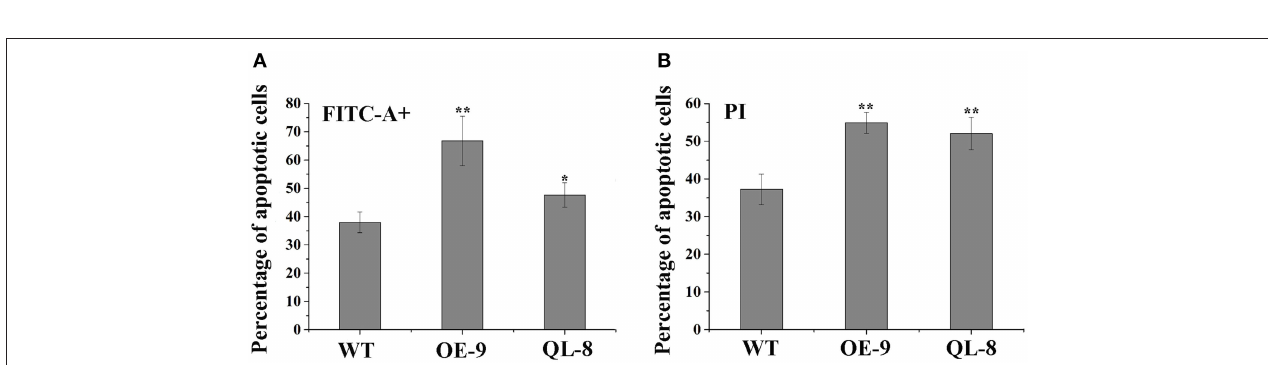
FIGURE 5 | Flow cytometry analyses of the protoplasts from poplar stem-differentiating xylem (SDX) stained with (A) annexin V-FITC and (B) propidium iodide (PI). Results are means ± SD of three biological replicates. Student’s t -test; * P < 0.05; ** P < 0.01.